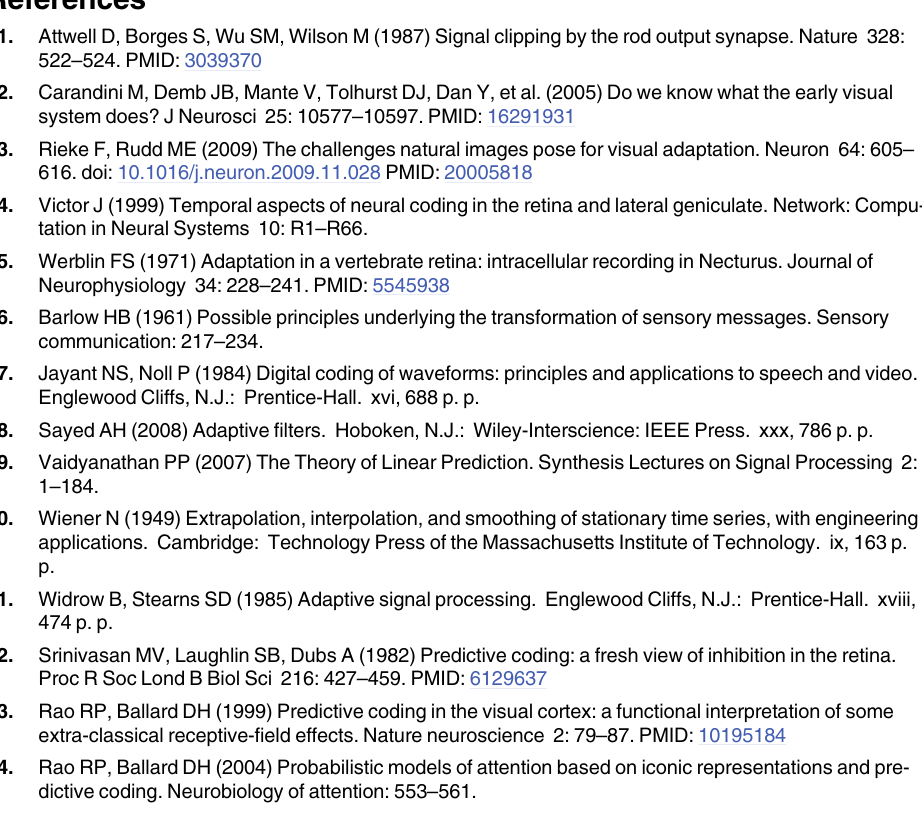
S5 Fig. Whitening effect of the optimal linear network for inputs with different SNRs. (a-e) Input power (blue) and the power within the optimal transfer function of the network (red) at different frequencies. SNR decreases from (a) – (e) (f-j) Output power at each frequency (obtained by multiplying both functions from left column). Notice the flat output power, termed whitening. Also, notice the reduction in total transmitted power. This reduction in power get progressively less as the fraction of predictable signal within the input reduces (i.e. as the SNR decreases). At the extreme case, in the final row, with pure noise, the input has the same power as the output, with no reduction of